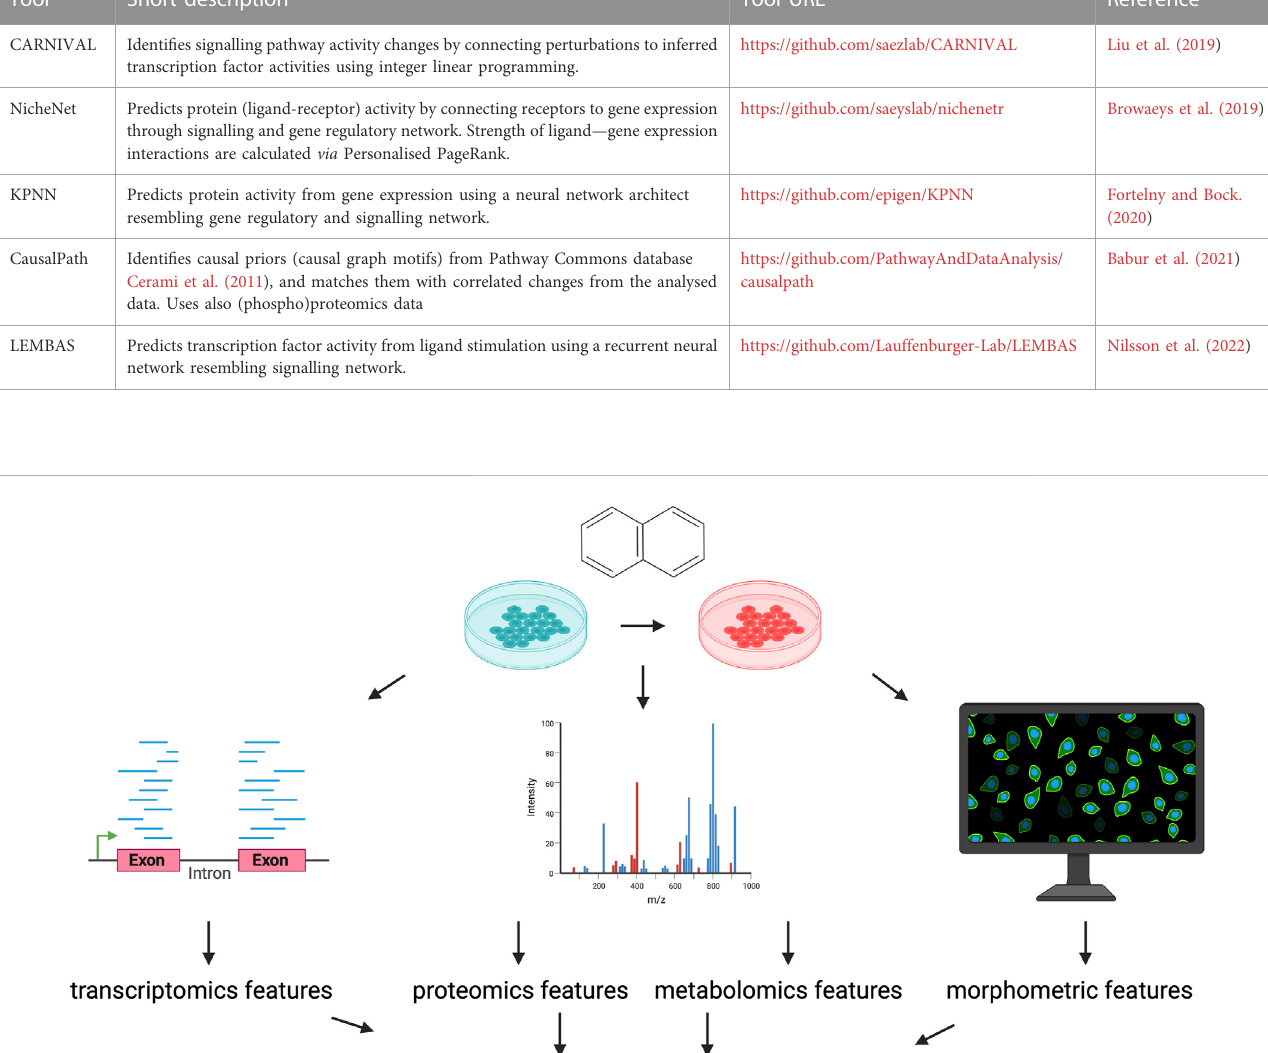
Frontiers in Systems